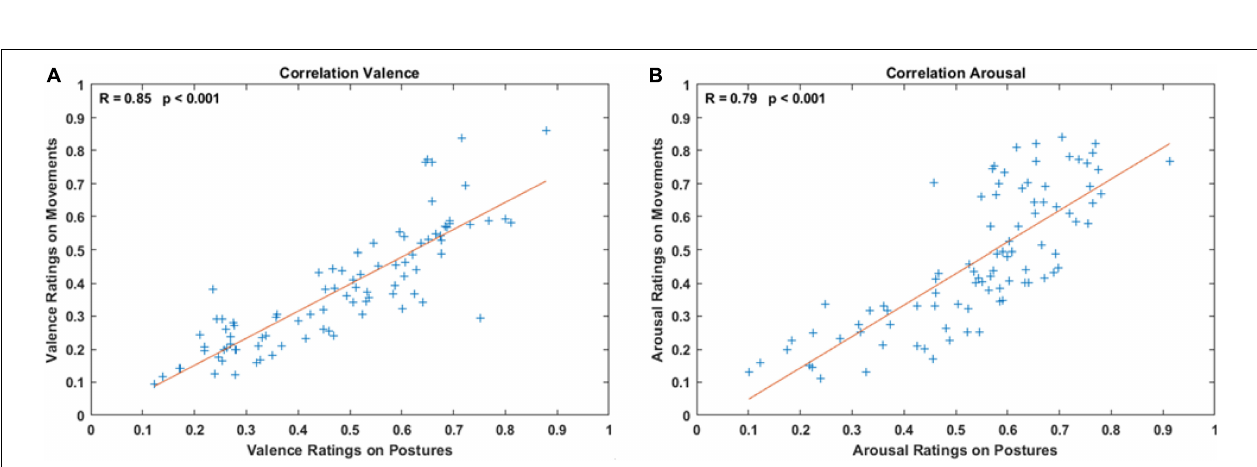
FIGURE 4 | Results of ANOVA on valence (Upper panels) and arousal (Lower panels) ratings. (Upper panels) Present mean and 95% CI of the distribution of the valence scores for the main factors body pleasantness (Left) , avatar (Middle) , and the interaction avatar × body pleasantness (Right panel) . (Lower panels) Present mean and 95% CI of the distribution of the arousal scores for the main factors body dynamicity (Left) , avatar (Middle) , and the interaction avatar × body dynamicity (Right panel) . Red asterisks indicate significant main effects, while black lines show significant pairwise comparisons.